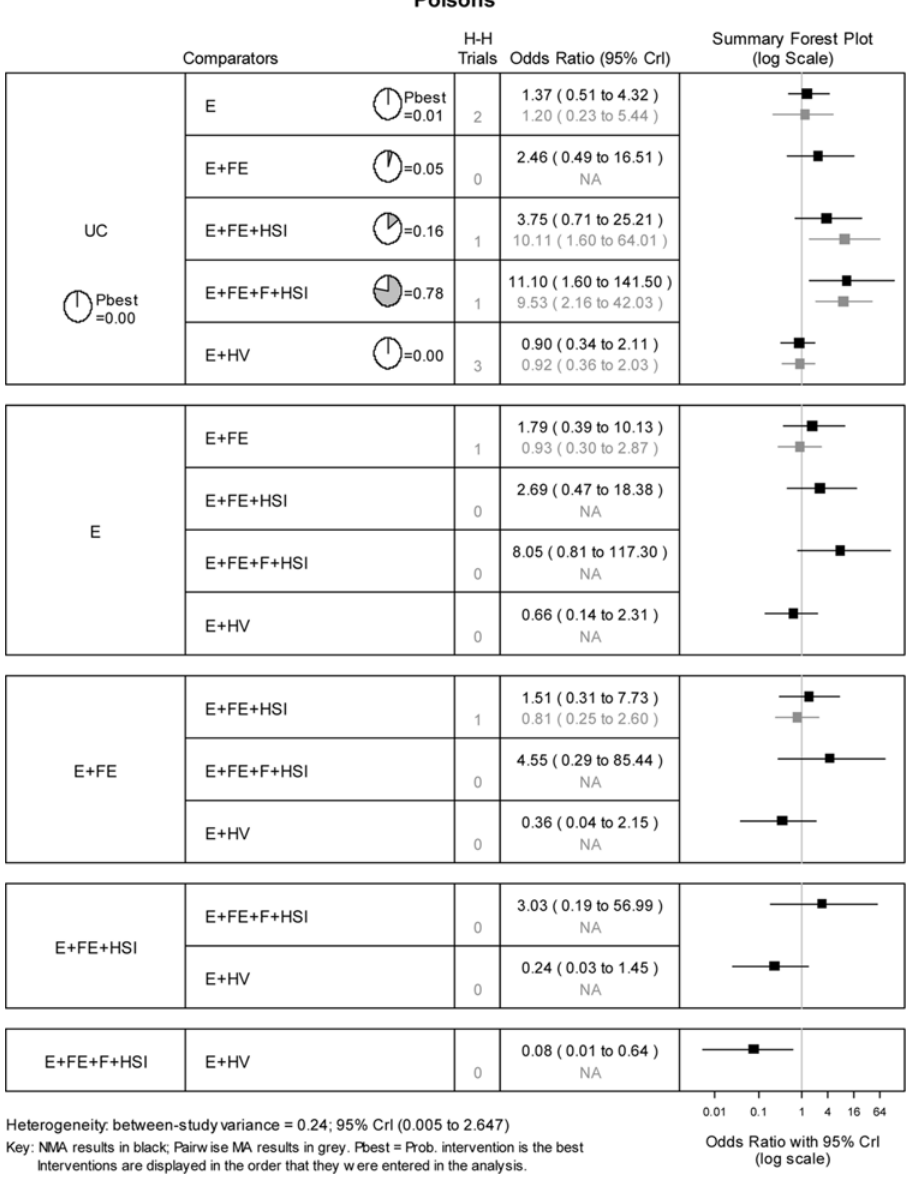
Fig 5. Network meta-analysis results for safe storage of poisons. H-H trials refer to the number of head- to-head trials available for the specified pairwise comparison.